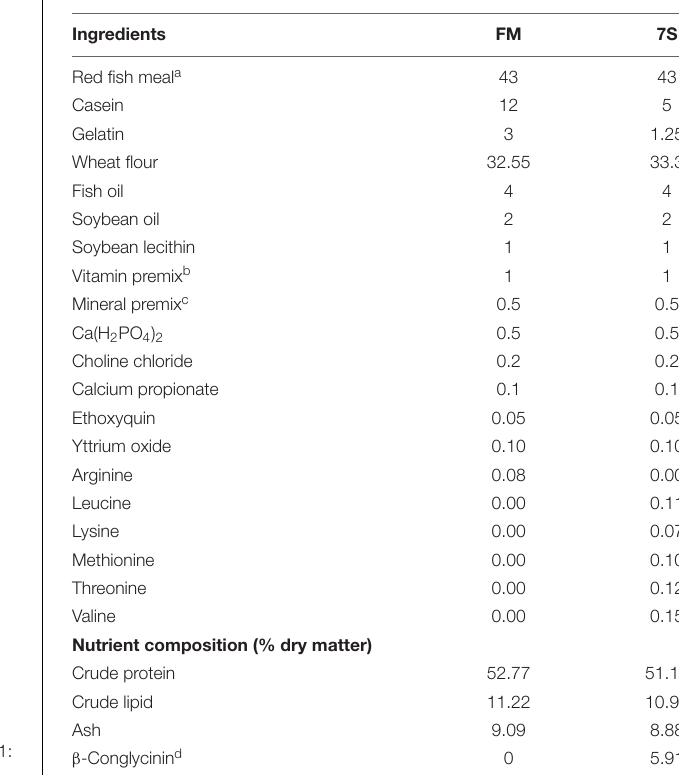
TABLE 1 | Formulation and proximate composition of the experimental diets (% dry